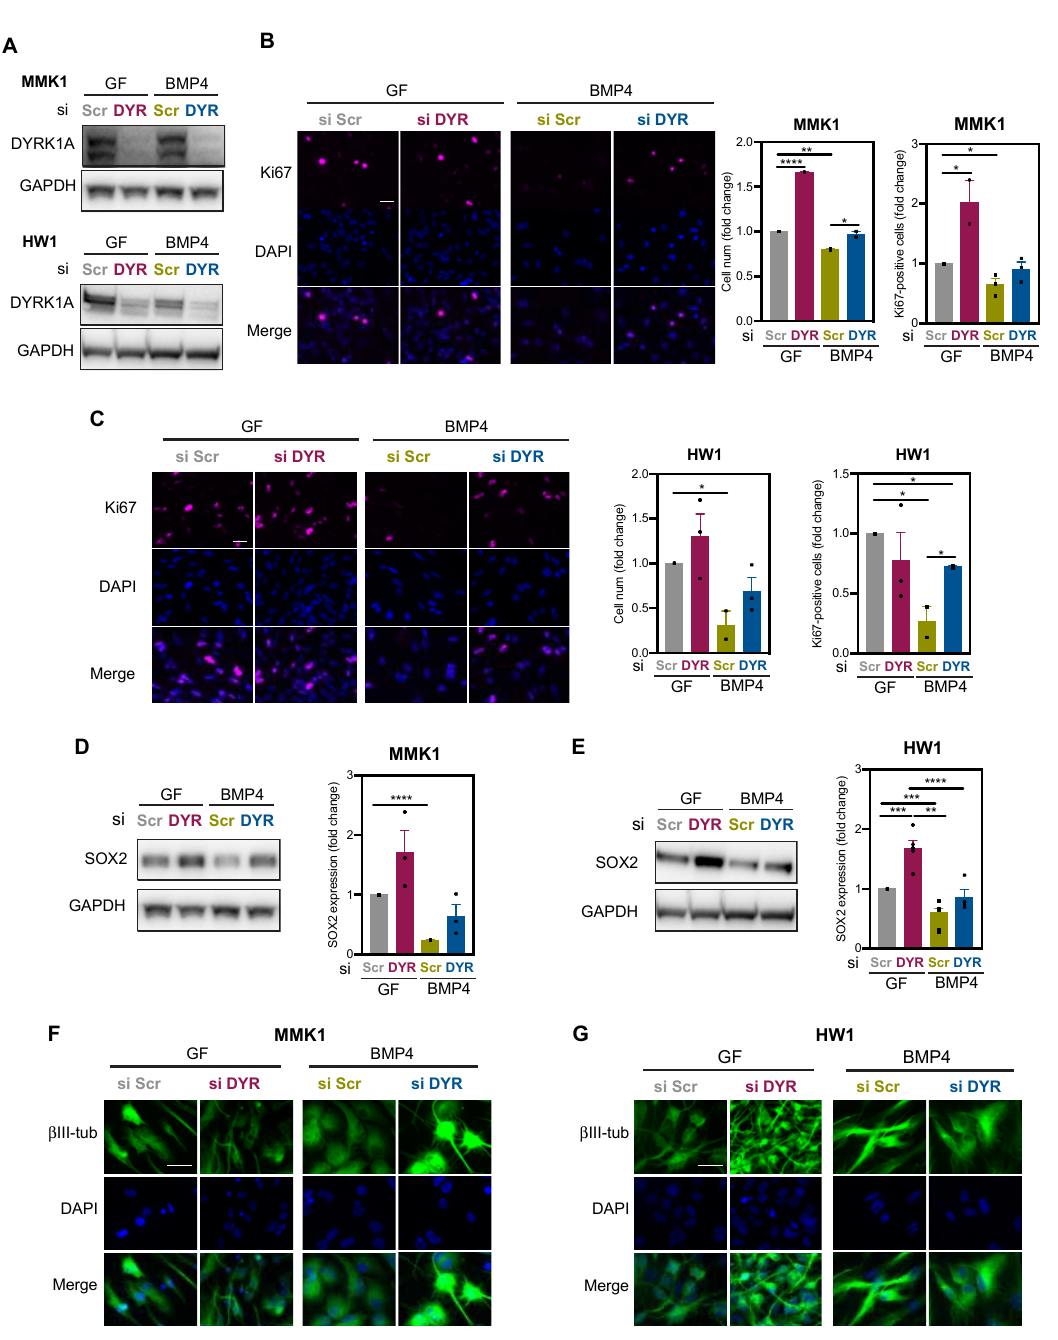
Figure 2. DYRK1A is essential for glioblastoma stem cells differentiation. MMK1 and HW1 cells were cultured with GF to maintain their stem-like phenotype. To induce differentiation, GF were replaced with BMP4 (20 ng/mL, 7 days). ( A ) Immunoblot images of DYRK1A expression in MMK1 and HW1 cells transfected with scramble (si Scr) and DYRK1A (si DYR) targeting siRNA, cultured with GF or BMP4 (7 days). ( B , C ) Immunofluorescence images and quantification of Ki67-positive MMK1 ( B ) and HW1 ( C ) cells transfected with scramble (si Scr) and DYRK1A (si DYR) targeting siRNA, cultured with GF or BMP4 (7 days). DAPI was used to visualise cell nuclei. Scale bar: 10 µ m. ( n = 2–3). ( D , E ) Immunoblot images and quantification of SOX2 expression in MMK1 ( D ) and HW1 ( E ) cells transfected with scramble (si Scr) and DYRK1A (si DYR) targeting siRNA, cultured with GF or BMP4 (7 days). ( n = 2–4). ( F , G ) Immunofluorescence images and quantification of β III-tubulin ( β III-tub) in MMK1 ( F ) and HW1 ( G ) cells transfected with scramble (si Scr) and DYRK1A (si DYR) targeting siRNA, cultured with GF or BMP4 (7 days). Scale bar: 10 µ m. All bar graphs represent mean ± SEM (two-tailed, unpaired t-test, * p < 0.05, ** p < 0.01, *** p < 0.001, **** p <